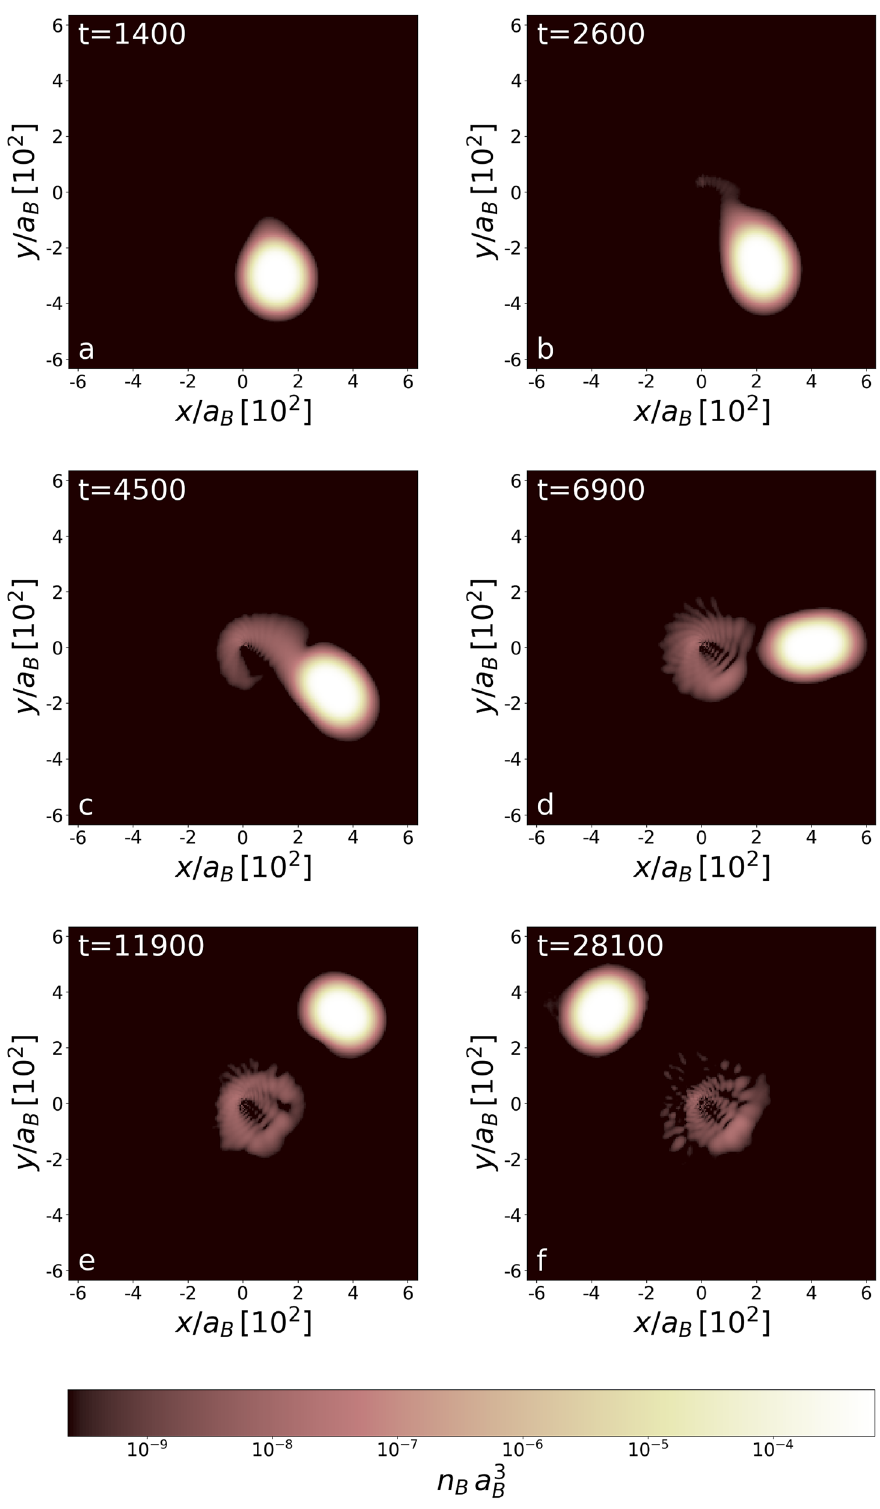
0 plane) of bosonic component at times during (frames a – c ) and after Figure 1. Density distribution (at z = 2 (cid:31) (see (frames e , f ) the first-time periastron passage for the first considered orbit. The unit of time is ( m B a B )/ 2 “Methods”). Note that the distance 1 between ticks means 10 in units of a B . An atomic white dwarf is stripped 5 of about 10 − of its mass. The stripped mass forms an accretion disk around the black hole. Frames show densities at various times during the first revolution, when mainly bosonic matter contributes to an accretion disk. The black hole is located at the center of each image and the Schwarzschild radius is small, below the unit of length a B